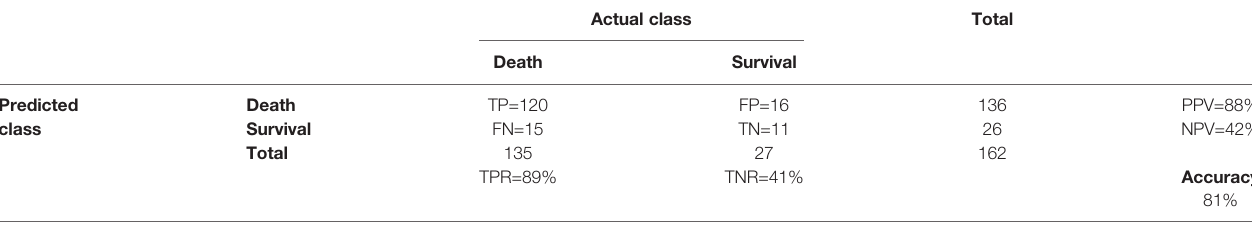
TABLE 3 | Confusion matrix for the model with hemoglobin levels above the median (>13.6